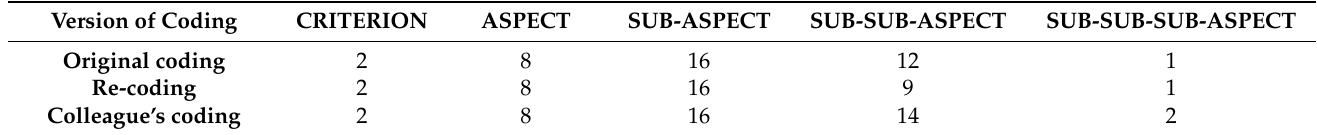
Table 1. Inter-rater reliability: Number of codes per classification of oral sub-skills into categories for ST Y608. Version of Coding